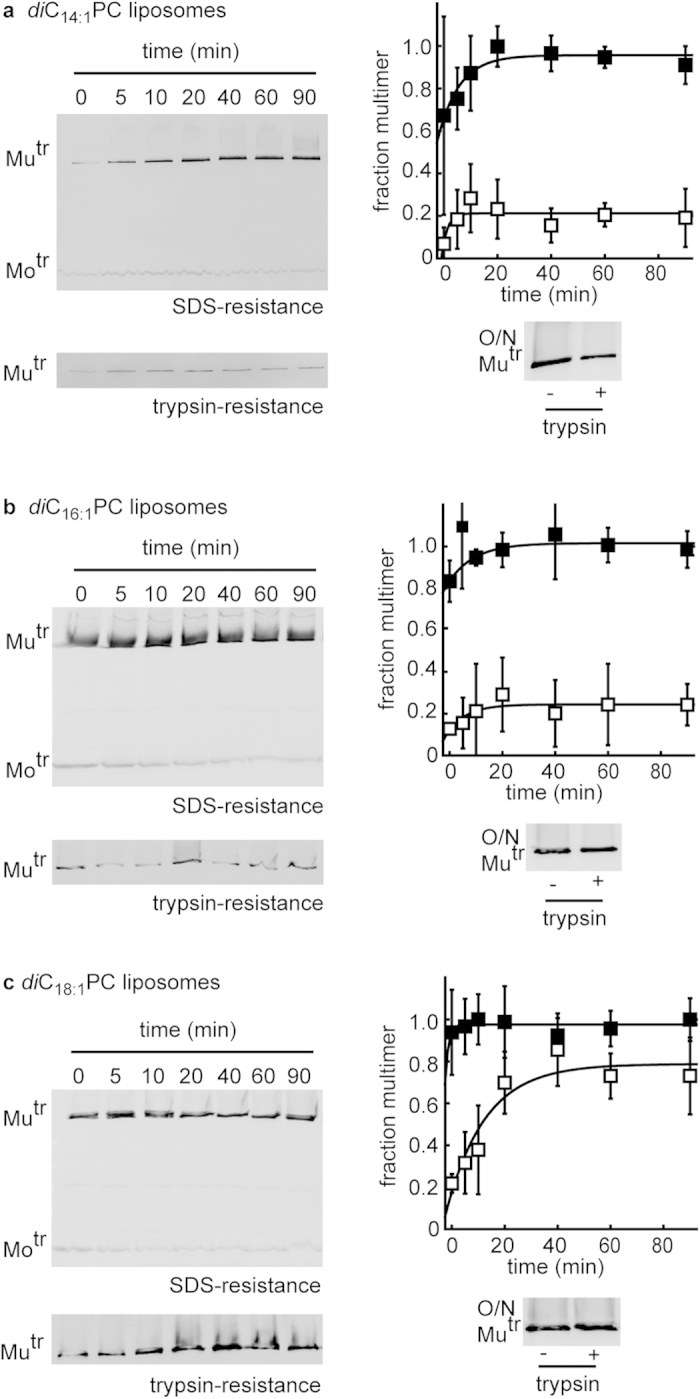
Kinetics of PulD28–42/259–660 folding in phosphatidylcholine (PC) liposomes with increasing hydrophobic thickness.(a) Multimerisation kinetics by acquisition of SDS- (◼) and trypsin- (◻) resistance in the presence of 53 mM diC14:1PC-liposomes. (b) Multimerisation kinetics by acquisition of SDS- (◼) and trypsin- (◻) resistance in the presence of 53 mM diC16:1PC-liposomes. (c) Multimerisation kinetics by acquisition of SDS- (◼) and trypsin- (◻) resistance in the presence of 53 mM diC18:1PC-liposomes. Errors represent S.D. over 3 independent measurements. (a–c) also show trypsin-resistance after overnight (O/N) incubation in the respective liposomes. Mutr and Motr indicate the migration position of multimeric and monomeric PulD28–42/259–660 species, respectively.